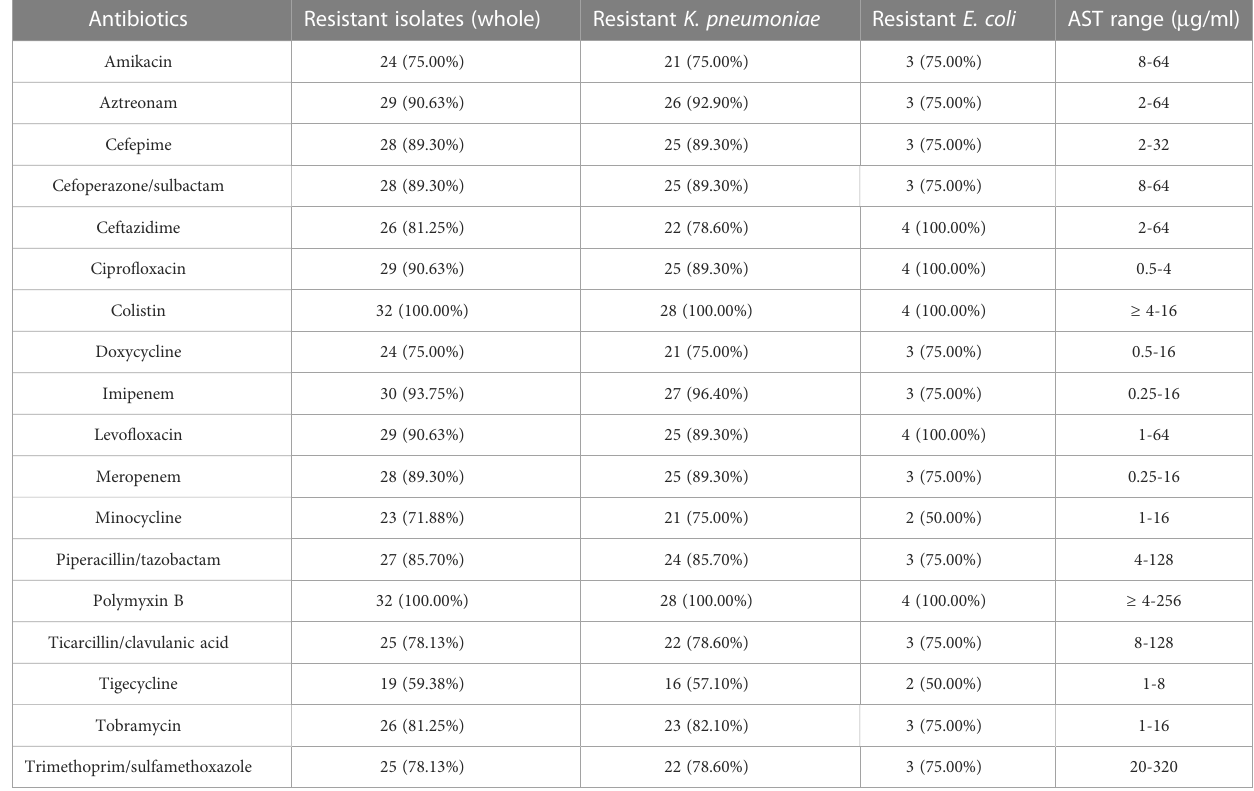
TABLE 2 Antimicrobial susceptibilities of polymyxin-resistant K. pneumoniae and E. coli isolates. Antibiotics Resistant isolates